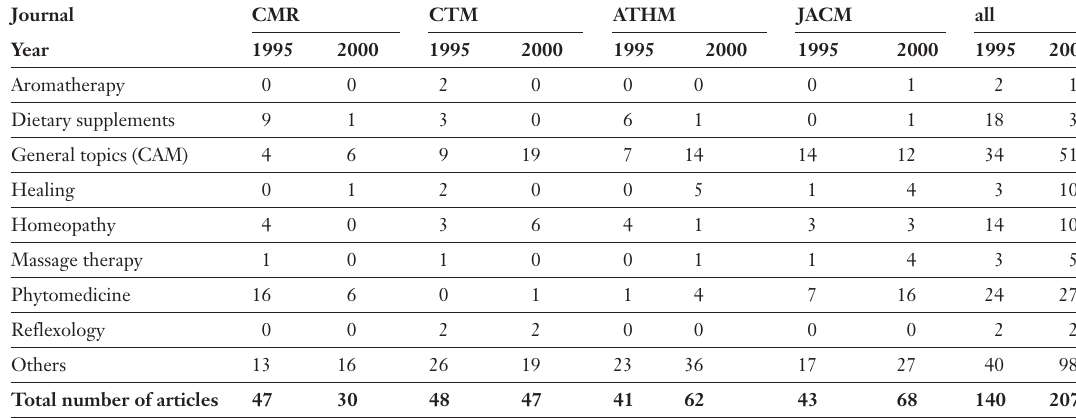
Table 3 Subject area. Values are absolute